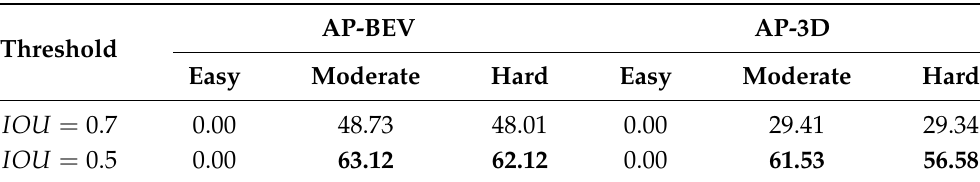
Table 1. The average precision (AP) of the object detection for different IOU values in the valida- tion dataset.